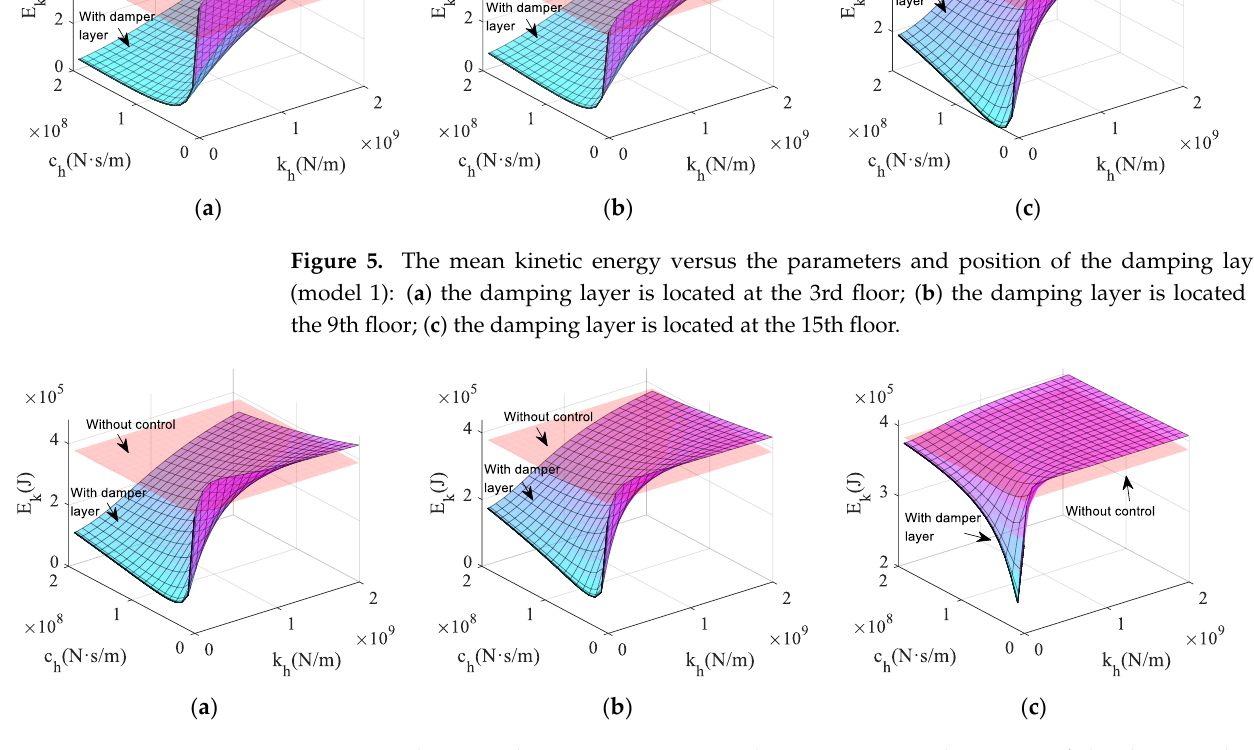
( c ) Figure 7. The mean kinetic energy versus the parameters and position of the damping layer (model 3): ( a ) the damping layer is located at the 3rd floor; ( b ) the damping layer is located at the 9th floor; ( c ) the damping layer is located at the 15th floor. Figures 6 and 7 show the dependence between the mean kinetic energy and the pa- rameters and position of the damping layer for models 2 and 3. Although similar trends are observed between the three models, there are slight variations as well. For one, when the optimal damping parameter is obtained for model 2, the area of the optimal parameter is narrower than for model 1, meaning that the area for model 1 is flatter. This phenome- non is most evident when the damping layer is placed at a higher floor, e.g., the 15th floor. For model 3, the curved surface depicting the mean kinetic energy over the parameters is flatter. The mean kinetic energy remains at a lower value than in model 1 (e.g., when the damping layer is located at the third floor, the corresponding minimum energies of model 3 and model 1 are 5.018 × 10 4 J and 5.496 × 10 4 J, respectively). The above mentioned results mean better control performance and robustness with the damping layer located in the stiffer building for model 3. In general, when the damping layer is situated in the stiffer tower and on a lower floor, it improves the damping effect and leads to a greater energy concentration and dissipation on the damping layer. Thus, the preferred damping effect can be achieved. 4.4. Optimal Parameters and Energy Reduction Coefficients